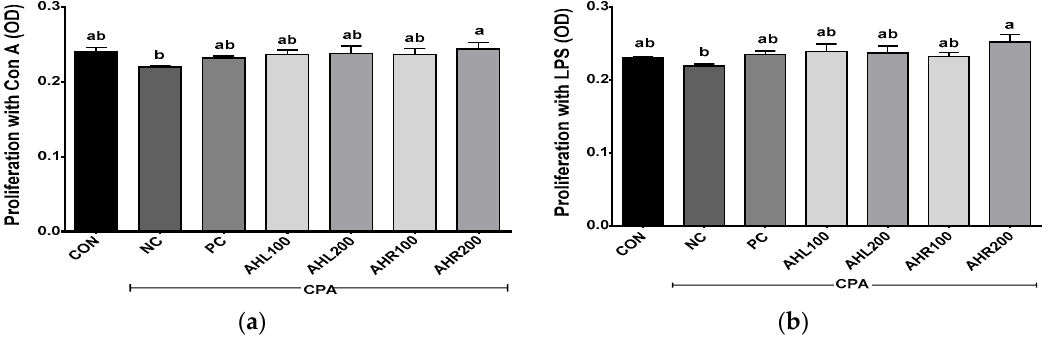
Figure 8. Effects of A. hookeri extracts on the proliferation of splenocytes treated with ( a ) Con A and ( b ) LPS in the C57BL/6 mice immunosuppressed by CPA. CON, normal control group; AHL100, A. hookeri leaves (AHL) extract 100 mg/kg BW; AHL200, AHL extract 200 mg/kg BW; AHR100, A. hookeri roots (AHR) extract 100 mg/kg BW; AHR200, AHR extract 200 mg/kg BW. Data was presented as the mean ± SEM (n = 12). a,b Different letters are significantly different at p < 0.05.